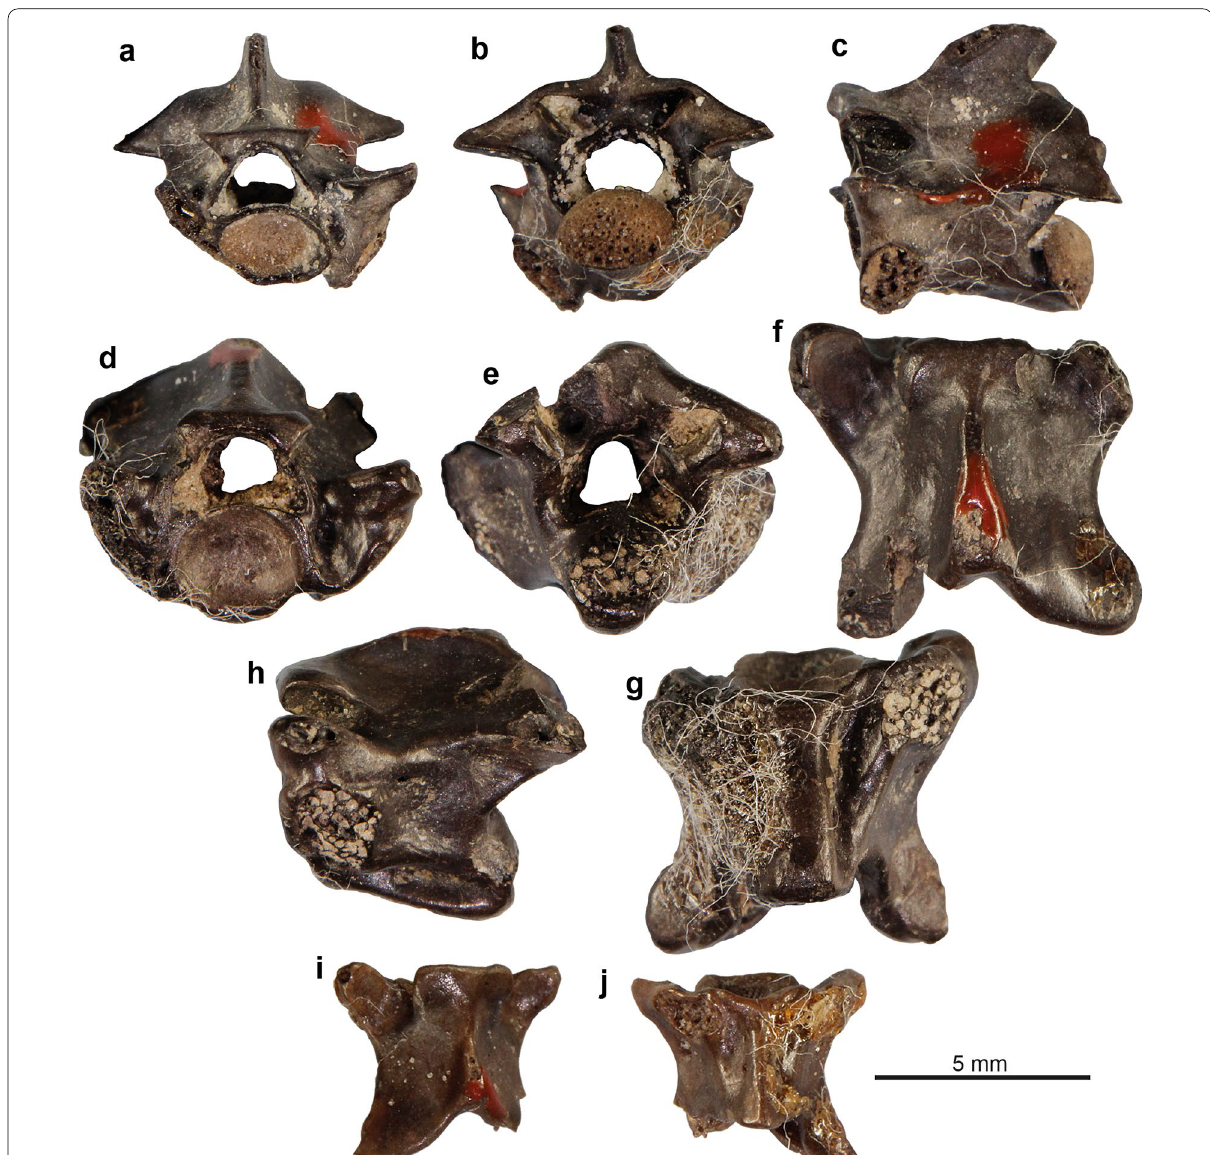
Fig. 35 Paleryx rhombifer from Hordle Cliff (type material of Paleryx depressus ): a – c lectotype (herein designated) mid-trunk vertebra (NHMUK PV OR 25261(1)) of Paleryx depressus in anterior ( a ), posterior ( b ), and left lateral ( c ) views; d – g paralectotype posterior trunk vertebra (NHMUK PV OR 25261(2)) of Paleryx depressus in anterior ( d ), posterior ( e ), dorsal ( f ), ventral ( g ), and left lateral ( h ) views; ( i , j ) paralectotype mid-trunk vertebra (NHMUK PV OR 25261(3)) of Paleryx depressus in dorsal ( i ) and ventral ( j )